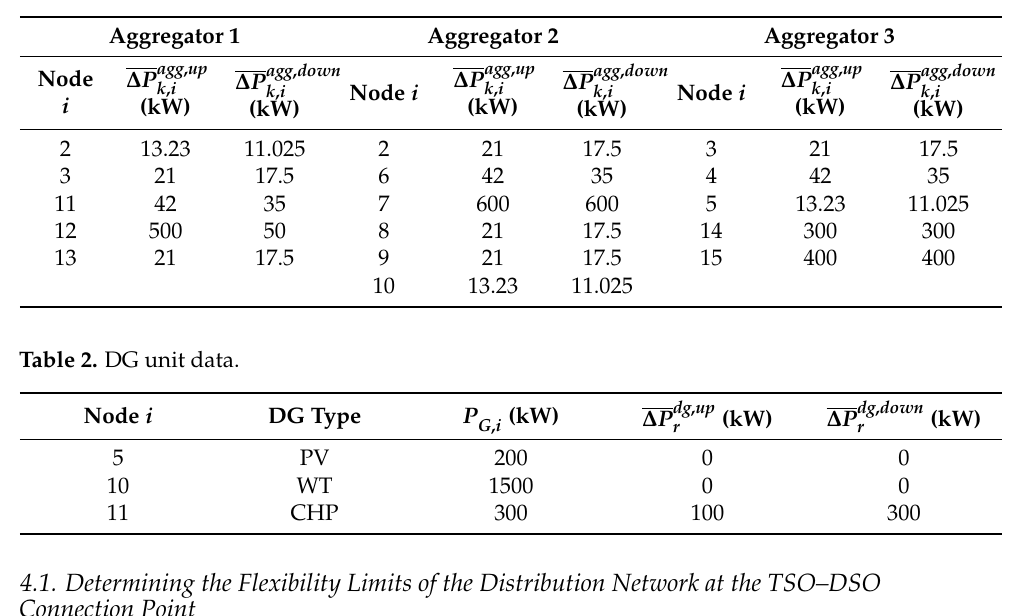
Figure 3. Modified IEEE 15-bus distribution network. Table 1. Aggregator data.